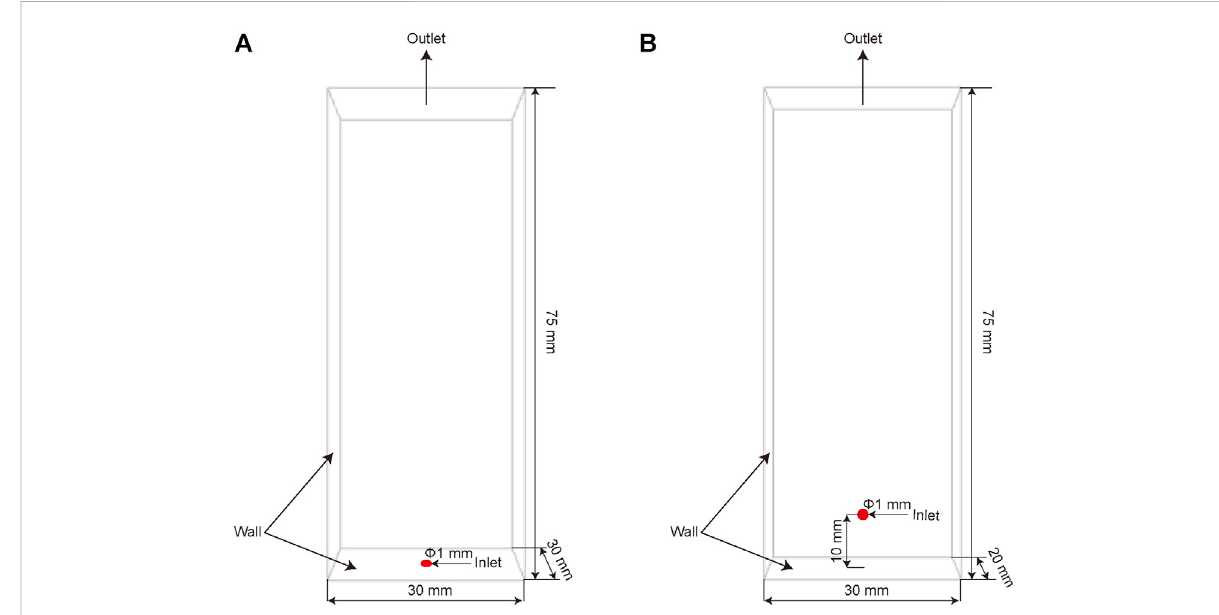
FIGURE 1 Schematic of the computational domain. (A) Bottom injection. (B) Wall injection.